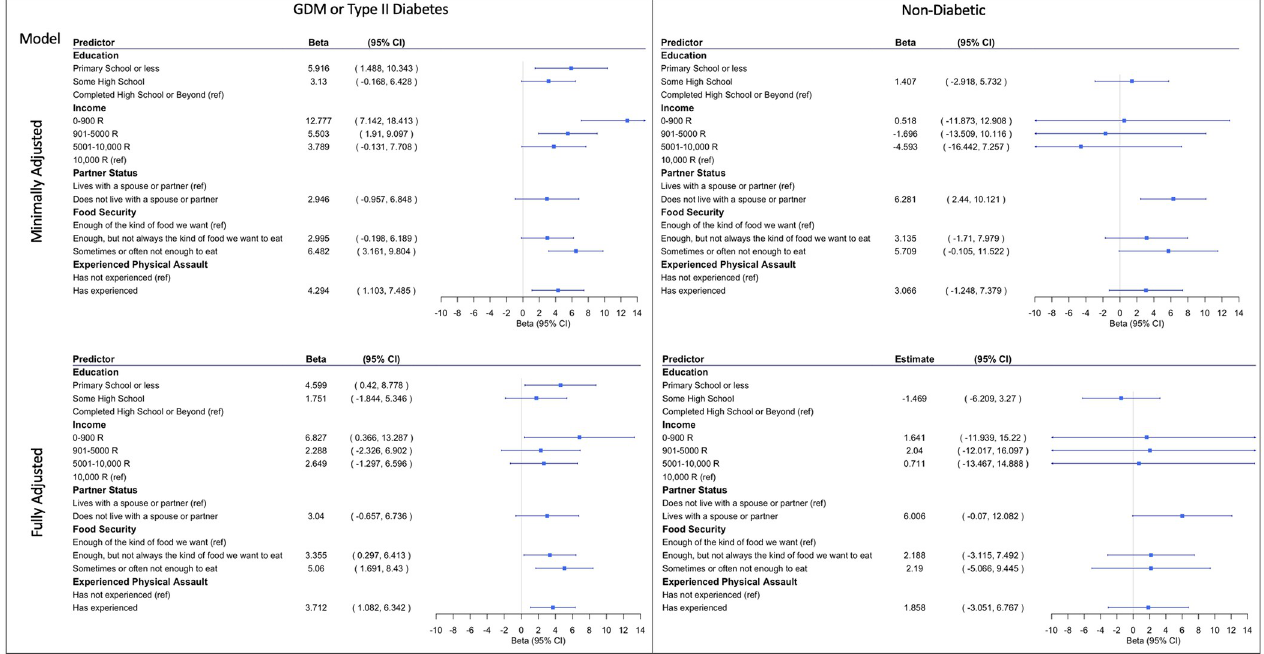
Fig 3. Stratified by diabetes betas and 95% CI for correlates of depression. Minimally adjusted model was adjusted for maternal age. Fully adjusted model was adjusted for maternal age as well as the other maternal experiences. Maternal physical assault and income were analyzed in separate models.